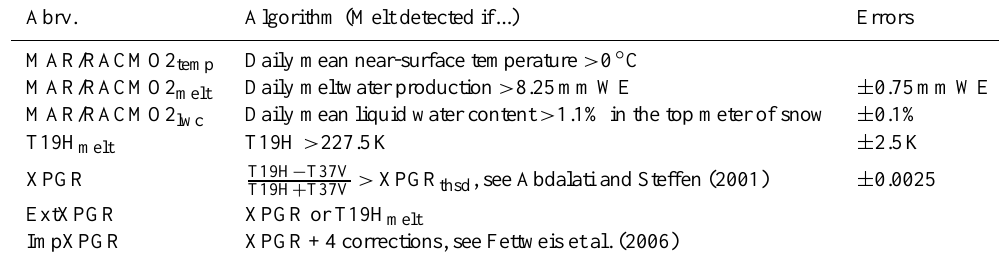
Table 2. Abbreviation of the different techniques discussed in the text to detect the melt. The errors bar range is also listed. Abrv.